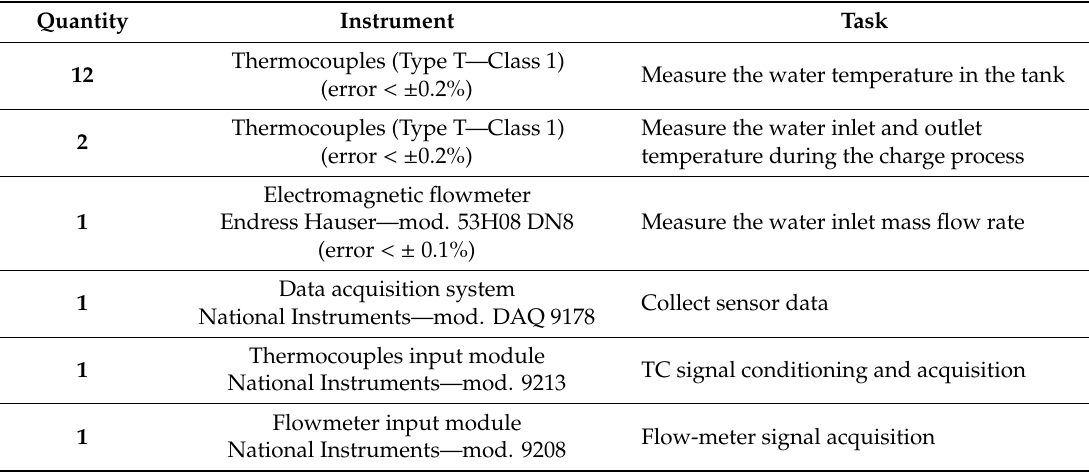
Table 2. Measurement devices used for the charge experimental